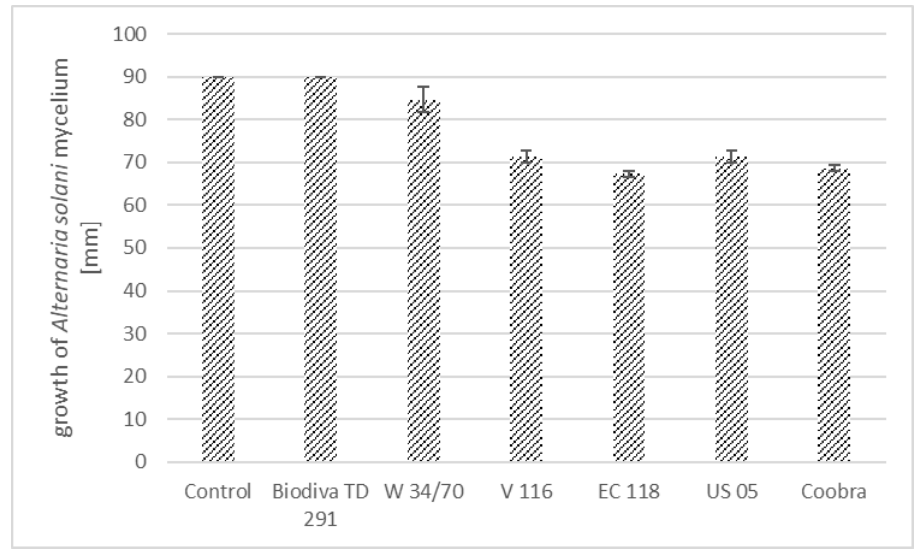
Figure 2. Inhibitory effect of antagonistic yeast strains on the growth of Alternaria solani mycelium after six days. Mycelium diameter in the cultures (mm) on Petri plates ± SD. Table 2. Inhibitory effect of antagonistic yeast strains on the growth of Alternaria solani mycelium three days after moving the fungal disc to the fresh medium.